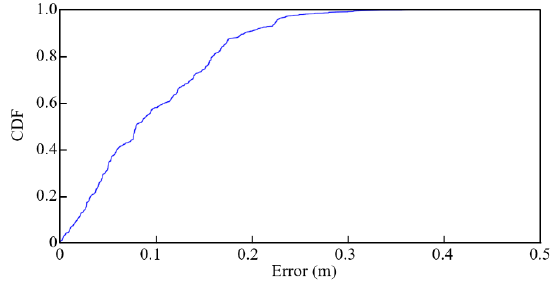
Figure 13. CDF of error in the experiment.